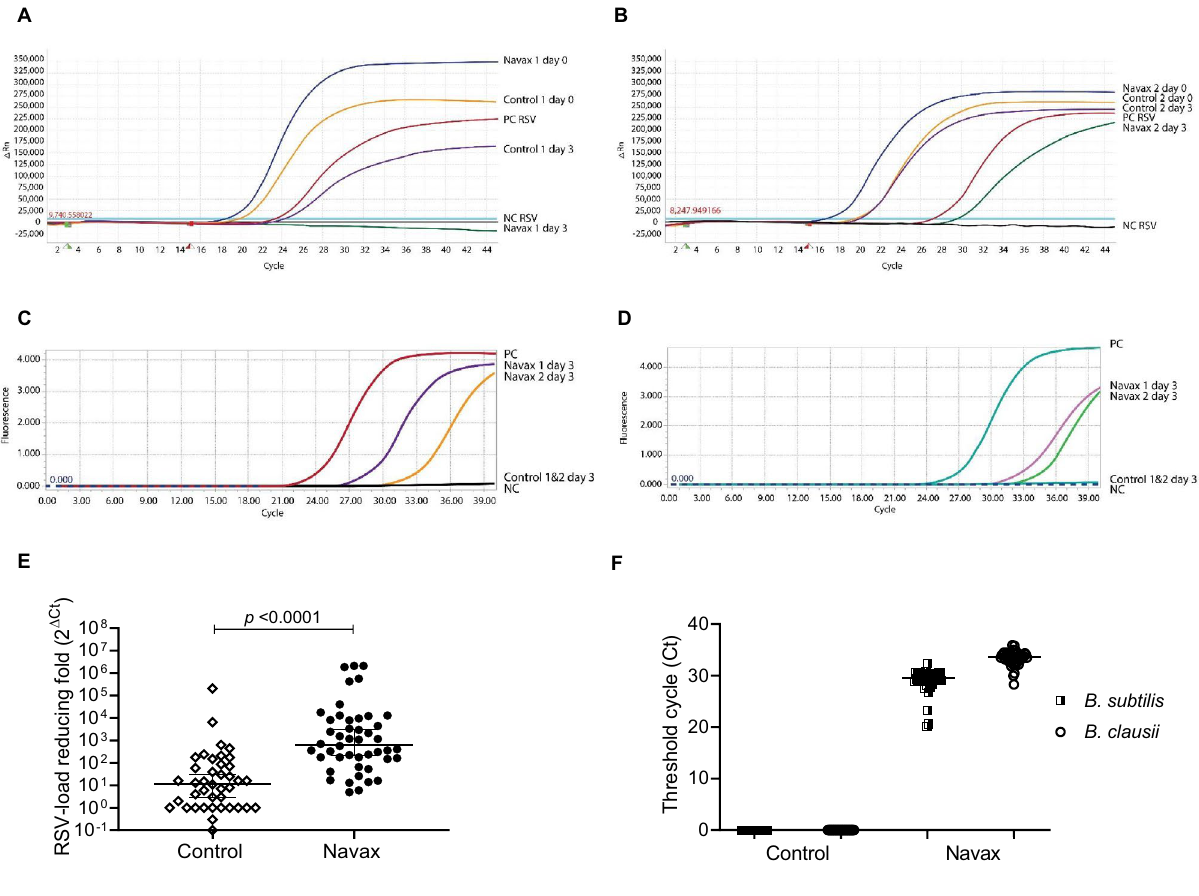
Figure 4. Real-time PCR TaqMan probes amplification curves ( A , B ) specifically for RSV taken from two representative nasopharyngeal samples of Control (Control 1_code N74, Control 2_code N66) and Navax groups (Navax 1_code N58, Navax 2_code N43) at day 0 and 3 of treatment. PC, NC are positive and negative controls of RSV; real-time PCR SYBR Green amplification curves specifically for B. subtilis ( C ) and B. clausii ( D ) taken from two representative nasopharyngeal samples of Control (Control 1, 2) and Navax (Navax 1, 2) groups at day 3 of treatment. PC, NC are positive and negative controls of B. subtilis and B. clausii ; Reducing-fold levels (2 △ Ct ) of RSV load in nasopharyngeal samples of Control and Navax groups at day 3 compared to day 0 ( E ). The Mann–Whitney test was used to calculate the median difference in viral load reduction in the two groups; Threshold cycle (C t ) of fluorescent signals for B. subtilis and B. clausii measured in nasopharyngeal samples of Control and Navax groups at day 3 ( F ).